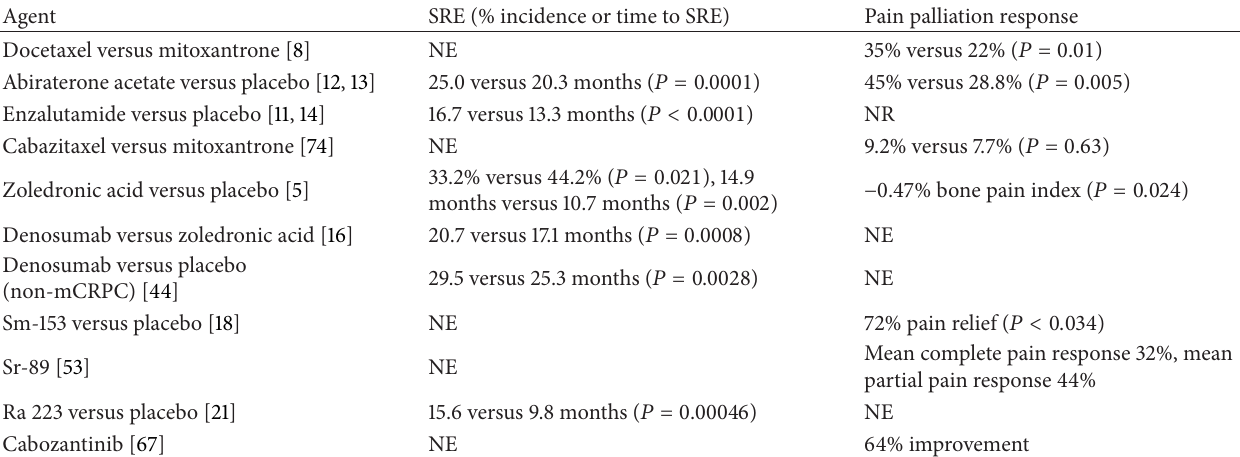
Table 2: The effect of selected agents on skeletal-related events (SREs) and pain palliation response based on randomized clinical trials. Agent SRE (% incidence or time to SRE) Pain palliation response Docetaxel versus mitoxantrone [8] NE 35% versus 22% ( 𝑃 = 0.01 ) Abiraterone acetate versus placebo [12, 13] 25.0 versus 20.3 months ( 𝑃 = 0.0001 ) 45% versus 28.8% ( 𝑃 = 0.005 ) Enzalutamide versus placebo [11, 14] 16.7 versus 13.3 months ( 𝑃 < 0.0001 ) Cabazitaxel versus mitoxantrone [74] NE 33.2% versus 44.2% ( 𝑃 = 0.021 ), Zoledronic acid versus placebo [5]